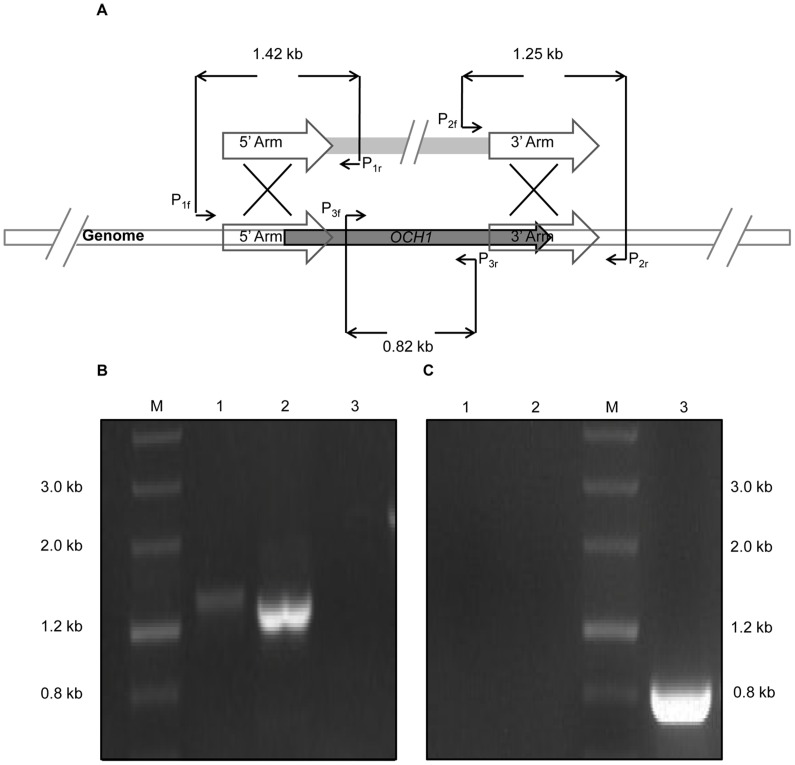
Verification of och1 mutant by polymerase chain reaction (PCR).A) Schematic representation of the OCH1 gene disruption and the primers used for verification. Three primer pairs were used. For the correct transformants, two bands with the size of 1.42 and 1.25 kb were amplified using the P1f/P1r and P2f/P2r primer pairs, respectively. No band was amplified using the P3f/P3r primer pair. B) Identification of och1 mutant by PCR with three primer pairs, P1f/P1r (Lane 1), P2f/P2r,(Lane 2), and P3f/P3r (Lane 3). C) Pichia pastoris GS115 strain was used as a negative control for PCR verification by using the three primer pairs, P1f/P1r (Lane 1), P2f/P2r (Lane 2), and P3f/P3r (Lane 3; the expected size of the band is 0.82 kb).